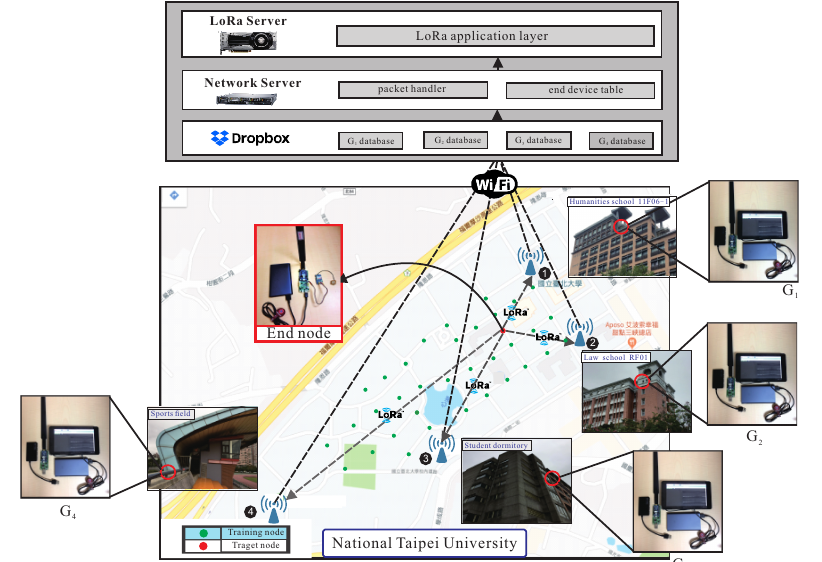
Figure 2. The outdoor environment of the large